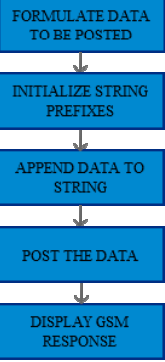
Figure 7. Block diagram of HTTP post.